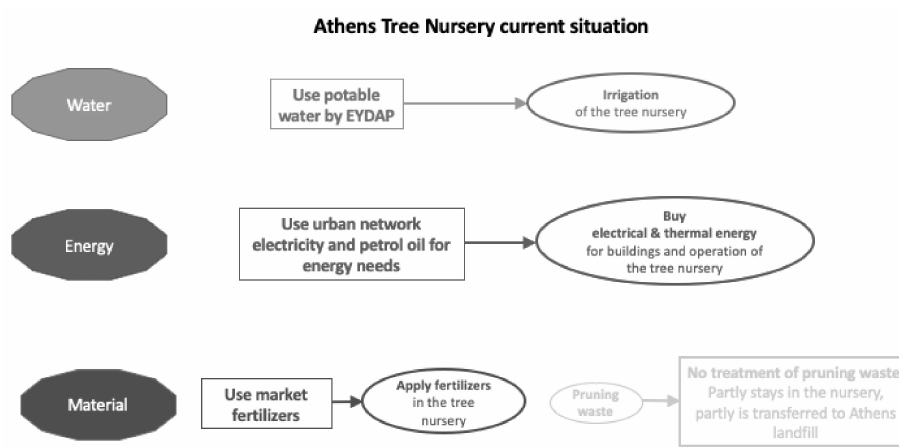
Figure 2. Linear baseline situation in Athens Plant Nursery in terms of water, energy and